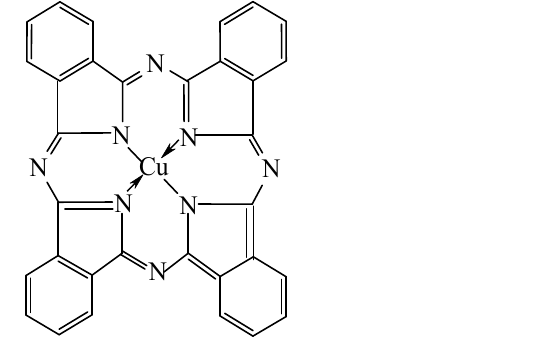
Figure 1. The structural formula of copper(II) phthalocyanine.